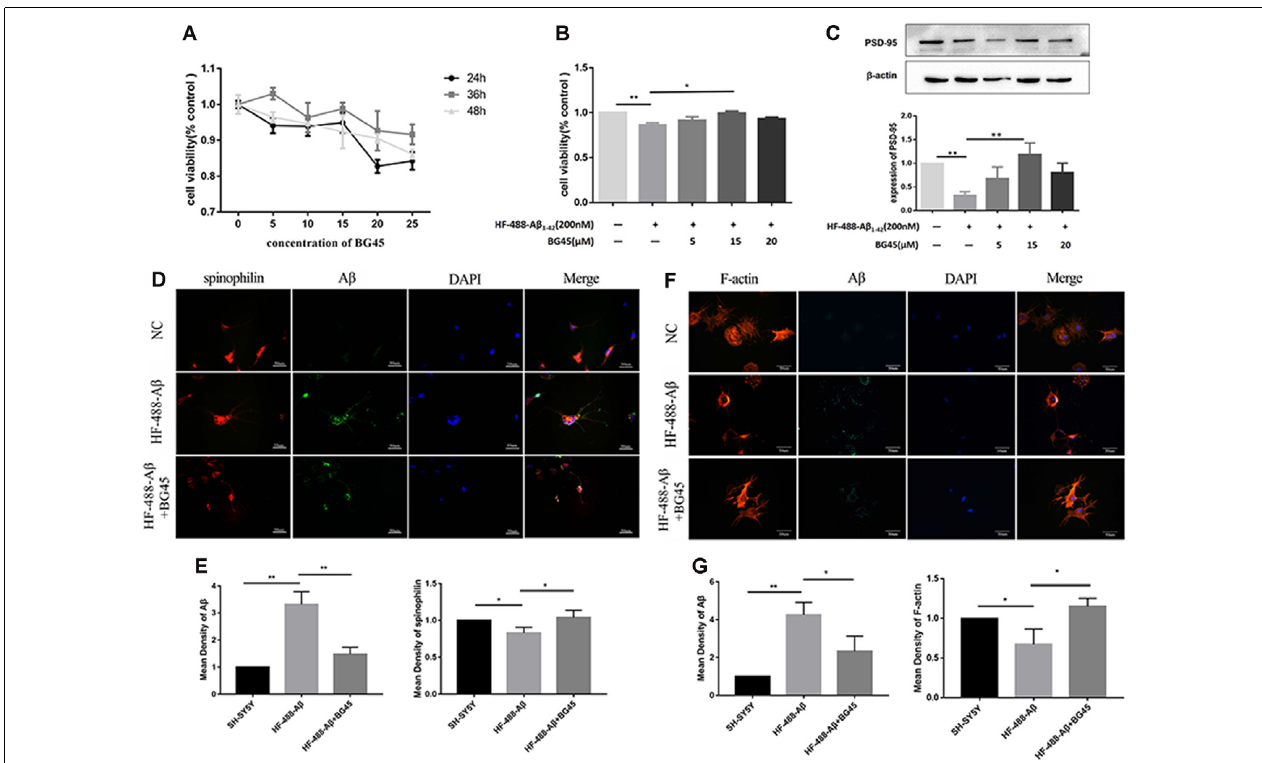
FIGURE 3 | The effect of BG45 on cell viability, expression of PSD-95 and spinophilin, and the cytoskeleton. (A) The viability of cells treated with vehicle or BG45 (5, 10, 15, 20, and 25 µ M) for 24, 36, and 48 h. (B) The cell viability of cells treated with vehicle, HF-488-A β (200 nM) or HF-488-A β (200 nM) + BG45 (5, 15, and 20 µ M). (C) Immunoblot analysis of PSD-95 from cells treated with vehicle, HF-488-A β or HF-488-A β + BG45 (5, 15, and 20 µ M) is shown as lanes. Quantification of PSD-95 is normalized to β -actin and is shown as a % of control, which reveals the significant differences between SH-SY5Y cells and HF-488-A β treated cells, as well as the differences between cells treated with HF-488-A β alone and cells treated similarly but with an additional 15 µ M BG45. (D) Immunofluorescence staining analysis of A β (green) and spinophilin (red) in SH-SY5Y cells treated with HF-488-A β or HF-488-A β + BG45 (15 µ M) for 36 h. (E) Quantitative A β and spinophilin analysis. (F) Immunofluorescence staining analysis of A β (green) and F-actin (red) in SH-SY5Y cells treated with HF-488-A β or HF-488-A β + BG45 (15 µ M) for 36 h. (G) Quantitative A β and F-actin analysis. All values are presented as the mean ± SD from three independent experiments. n = 5. * p < 0.05 and ** p < 0.01.